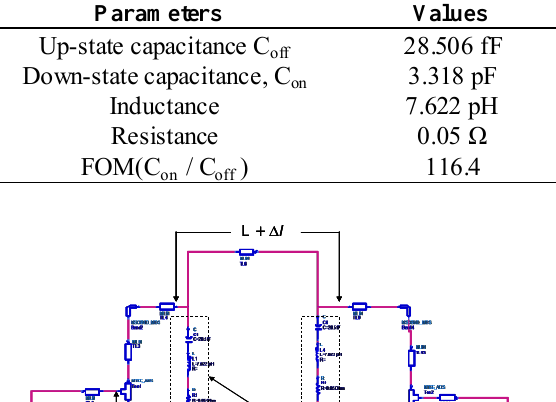
Table-VI: Model parameters of switch